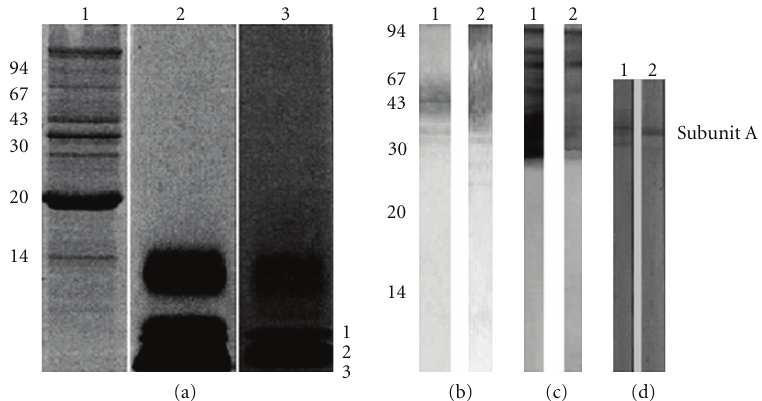
Figure 1: (a)(1) SDS-PAGE (13% gel) analysis of native OMPs of N. meningitidis ; (a)(2) LPS characterization and (a)(3) LPS immunoreactivity with monoclonal antibodies of N. meningitidis ; (b) E. coli stx1 (1) or stx2 (2) toxoid after silver stain. Standard markers are shown on the left of (a); (c) immunoblot of 13% SDS/PAGE and transfer to nitrocellulose membranes. Nitrocellulose membranes containing OMPs of N. meningitidis (lanes (c)(1) and (c)(2)) were incubated with 1:500 dilution of rabbit antiserum anti-OMPs-Stx1 or anti-OMPs-Stx2, respectively. Immunoblot with 100 μ g of toxoid Stx1 or Stx2; Lanes (d)(1) and (d)(2): IgG immunoreactivity of the monoclonal antibody anti-Stx1 or -Stx2, respectively, with the A subunit of the